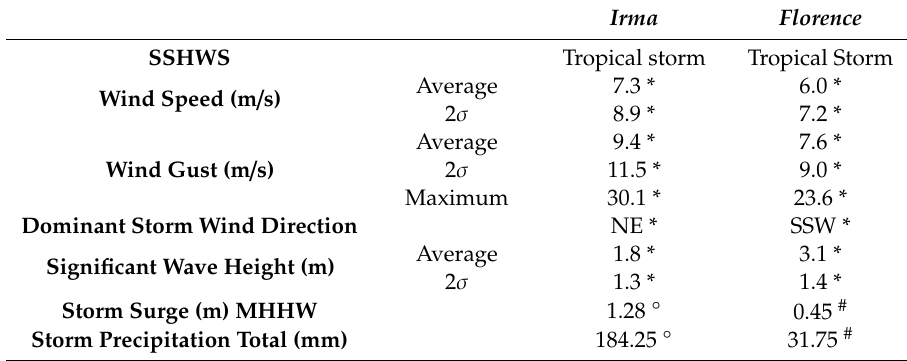
Table 1. Summary storm conditions during Irma and Florence obtained from the closest instrument(s) to Isle of